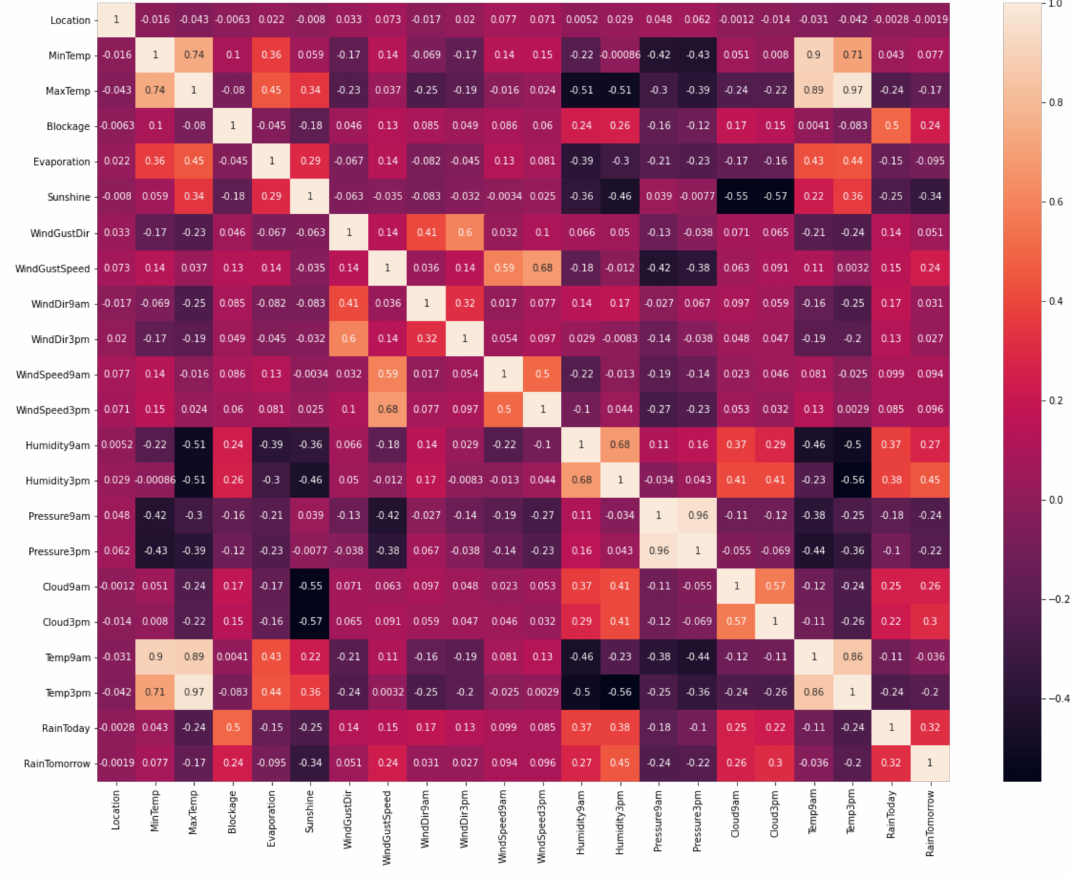
Figure 9. Correlation coefficient between